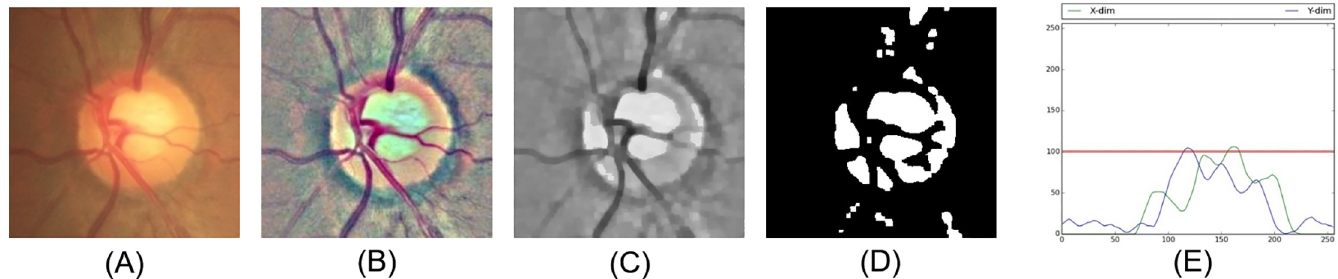
Fig 2. Process to determine noisy cases with incorrect ROI selection. (A) Color fundus image; (B) fundus image after preprocessing; (C) further preprocessing on the red and green channel; (D) binary display of the image; (E) histogram of the projection on x-axis and y-axis, which indicates correct ROI selection with both peaks of the axes located at the center. ROI, region of interest.